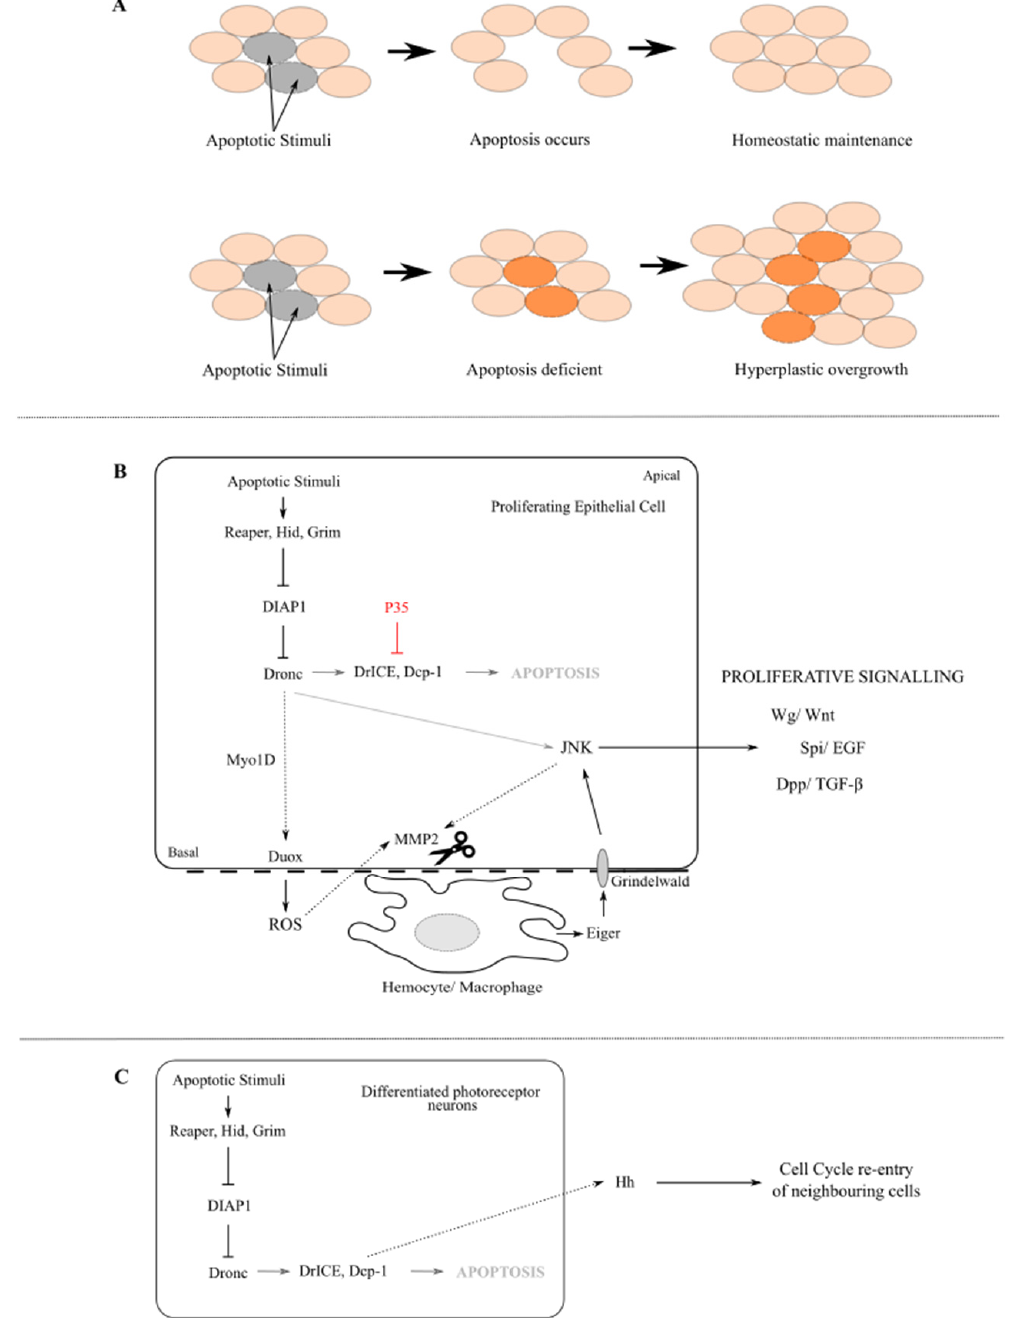
Figure 5. Apoptosis-induced Proliferation (AiP). ( A ) Roles of AiP in homeostatic maintenance and tumourigenesis. ( B ) Mechanism of AiP in apoptosis-deficient proliferation cells leading to tissue overgrowth. The initiator caspase Dronc coordinates apoptosis and AiP in response to apoptotic stress. P35 inhibits DrICE and Dcp-1, therefore execution of apoptosis, but not Dronc. This allows continuous AiP resulting in tissue overgrowth. Myo1D interacts with Dronc and facilitates its re-localisation to the basal plasma membrane, where Dronc regulates Duox to stimulate production of ROS. ROS and JNK activate MMP2, which disrupts the basement membrane leading to recruitment of hemocytes (macrophages). Macrophages in turn secret Eiger and activates JNK via the TNF receptor Grindelwald in epithelial cells non-cell autonomously. Activated JNK drives hyperplastic tissue overgrowth and tumourigeneisis through activation of mitogens including Wg/Wnt, Dpp/TGF- β and Spi/EGF. ( C ) Mechanism of AiP in the differentiating eye tissue. In response to apoptotic stress, the executioner caspases DrICE and Dcp-1 in dying photoreceptor neurons activate the Hh growth signals, which secrete to their neighbouring cell cycle-exited but unspecified cells and drive their cycle